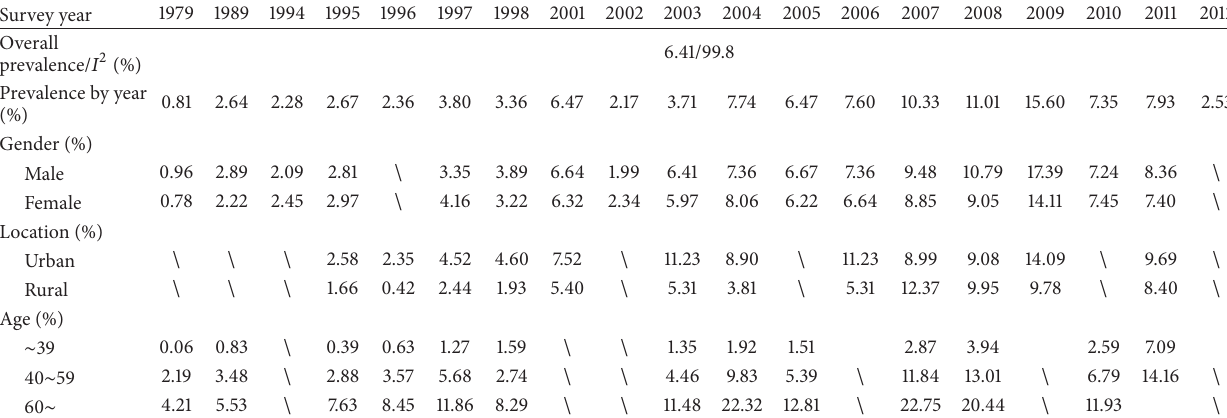
Table 2: Trends in prevalence of diabetes in mainland China: 1979 ∼